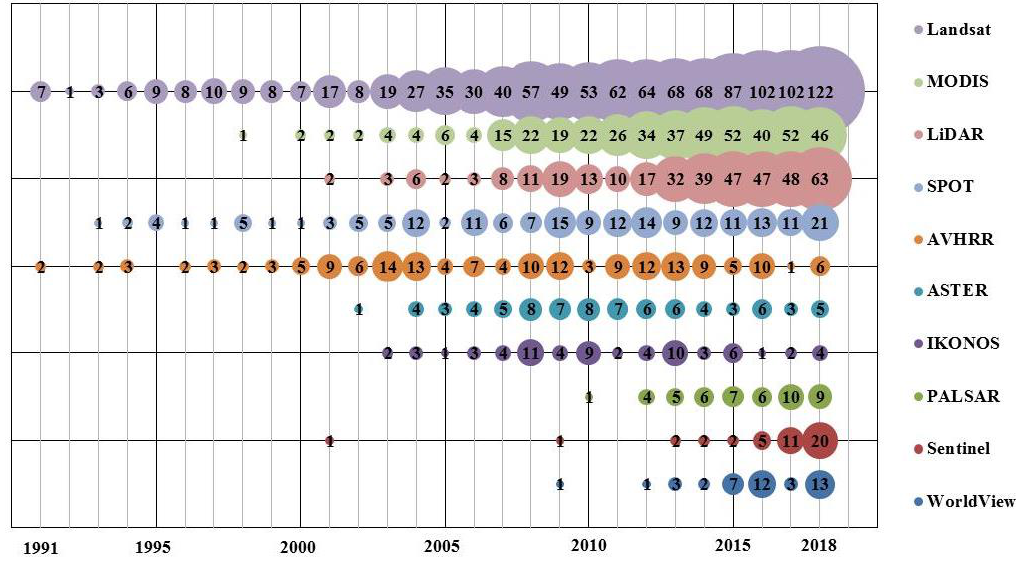
Figure 6. Annual publications of the main satellites and sensors in the research field.